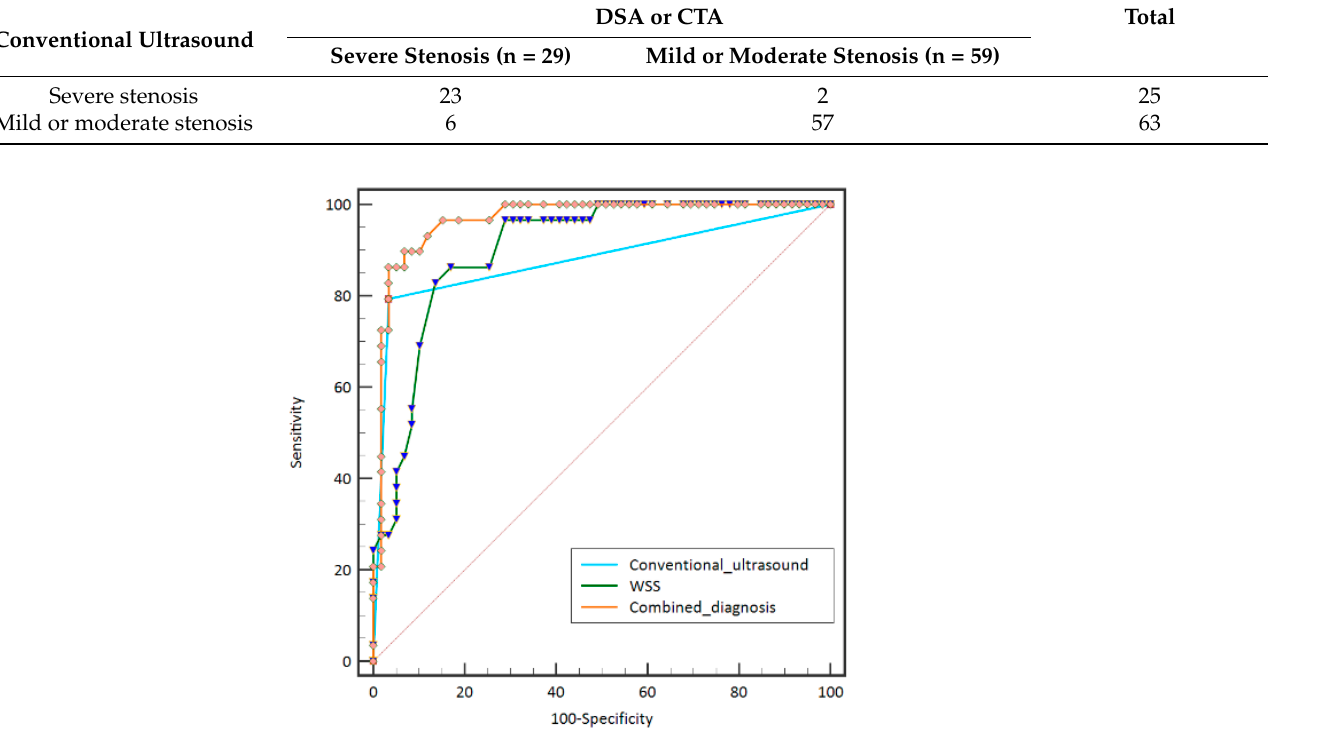
Figure 4. The comparison of diagnostic efficacy of wall shear stress (WSS), conventional ultrasound, and combined diagnosis in differentiating the severe carotid atherosclerotic